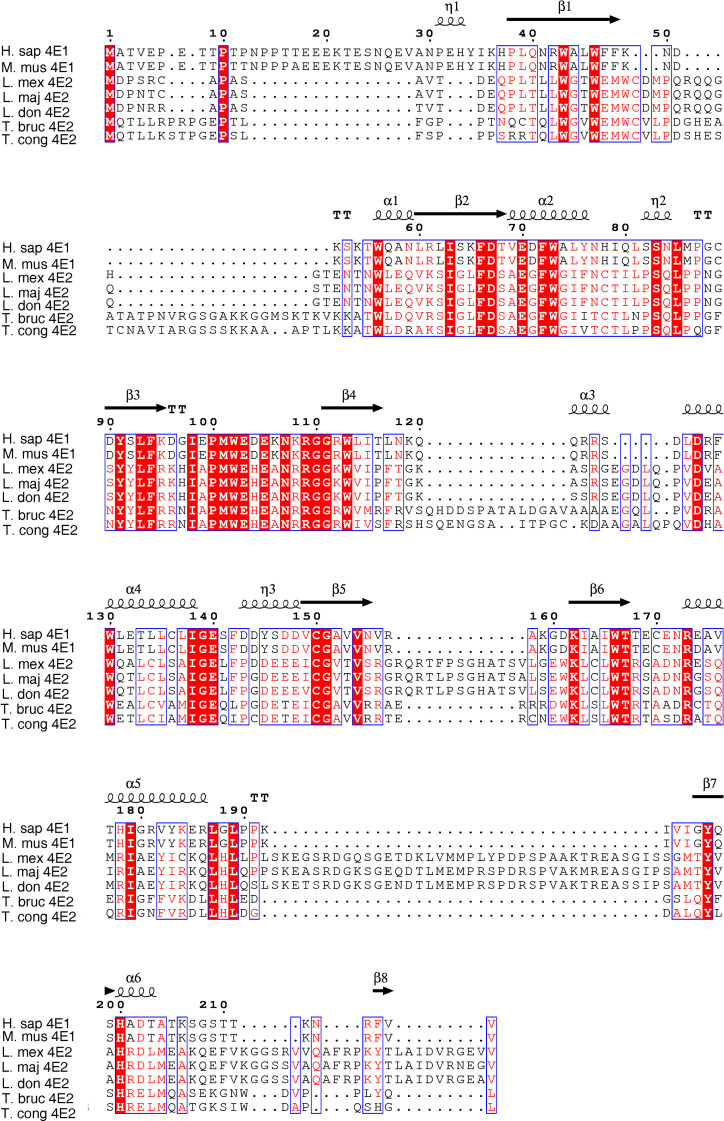
Multiple sequence alignment of the LeishIF4E2.(A)The ORFs of LeishIF4E2 from different Leishmania and Trypanosoma specis along with mammalian eIF4E1 were aligned using Jalview (2.10.5). The sequences were retrieved from L. mexicana (L. mex, LmxM.19.1480), L. major (L. maj, LmjF.19.1500); L. donovani, (L. don, LdBPK_191520.1), T. brucei (T. bruc, Tb927.10.16070) and T. congolense (T. cong, TcIL3000_0_03820). The alignment file was saved in FASTA format. The final alignment showing the predicted secondary structure of LeishIF4E2 was developed using the downloaded PDB file (5EHC, DOI: 10.2210/pdb5EHC/pdb) of Homo sapiens eIF4E1 (https://www.rcsb.org/), along with the FASTA alignment file, using the online ESPript 3 tool [60]. Secondary structure elements of the aligned sequences are (α: alpha helices, ƞ: 310-helix, β: beta-strands, TT: strict β-turns). White letters over a red background indicate identical residues and red letters over a white background indicate sequence similarity.